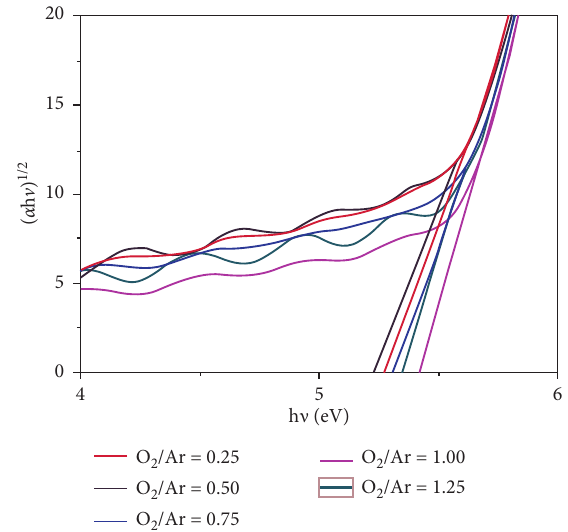
Figure 5: Spectral transmitivity of ZrO argon.